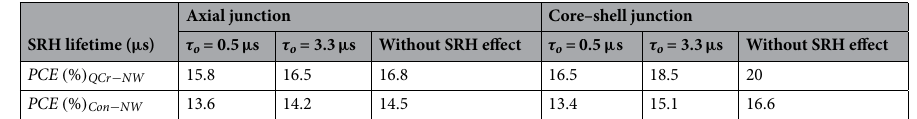
Table 4. The PCE of the proposed and conventional NW designs in the axial and core–shell junction at different lifetime values.